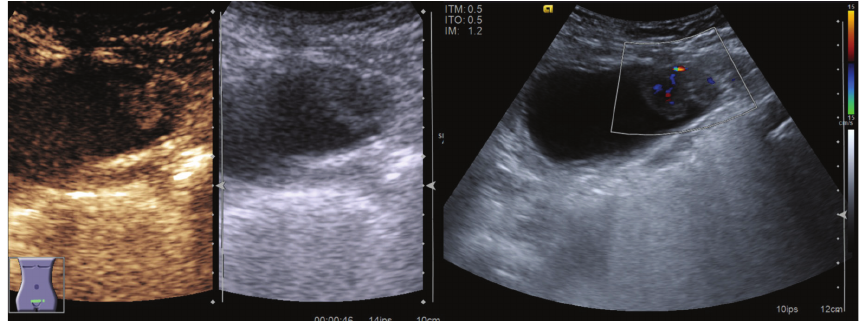
Figure 2: Pelvic US